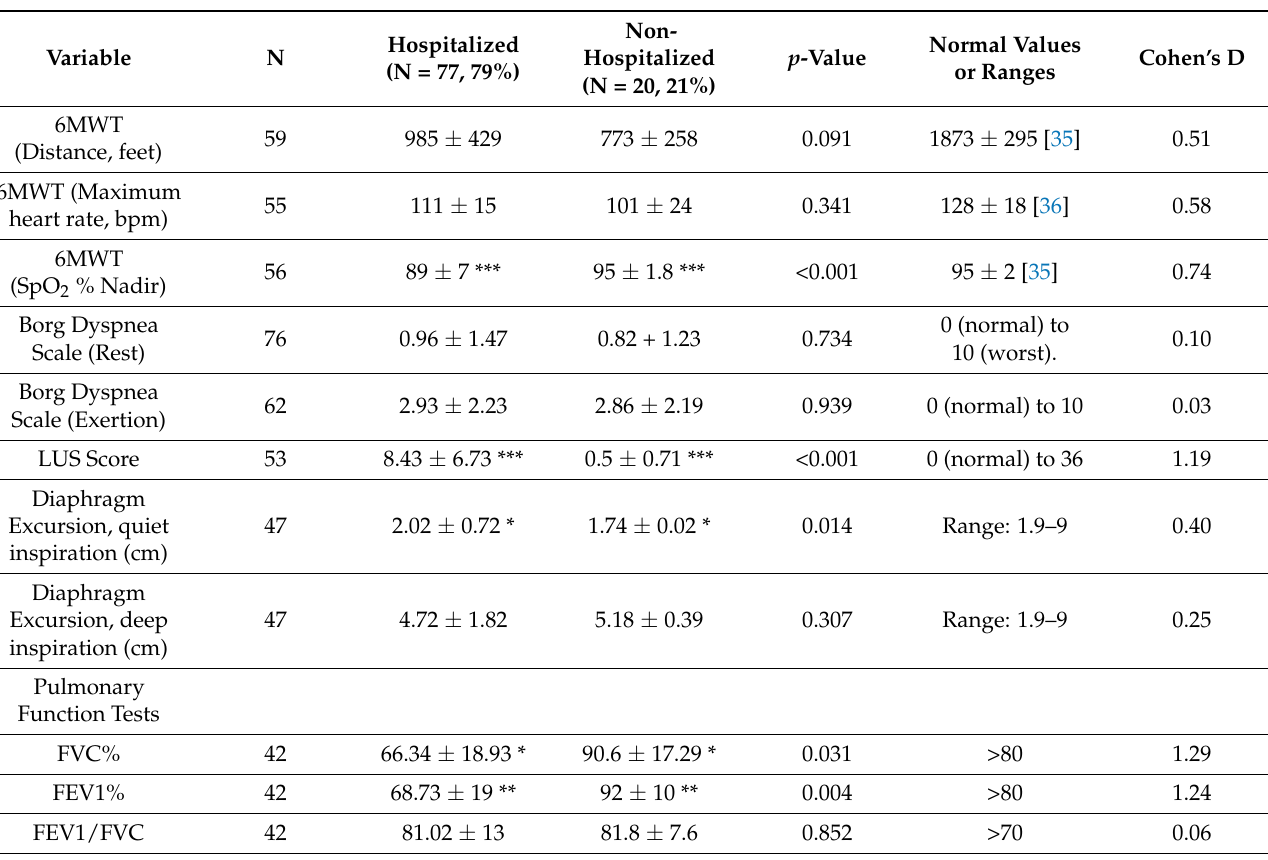
Table 3. 6MWT, Borg Dyspnea scale, LUS Score, Diaphragm Excursion Measurements and PFT